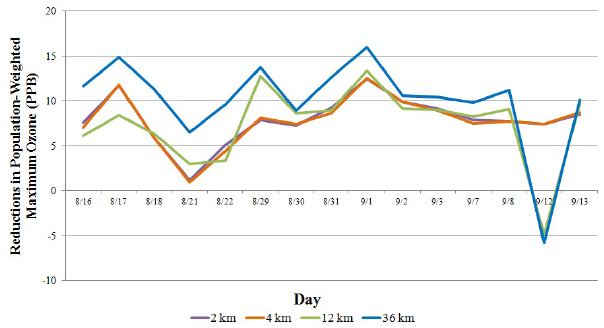
Fig. 4. Population weighted daily maximum 8-h averaged ozone concentrations calculated using fine scale 2km population, and ozone concentration data measured at monitors (green), or modeled ozone values from only the grid cells containing monitors from both the 2006 (red) and 2018 (purple) runs.